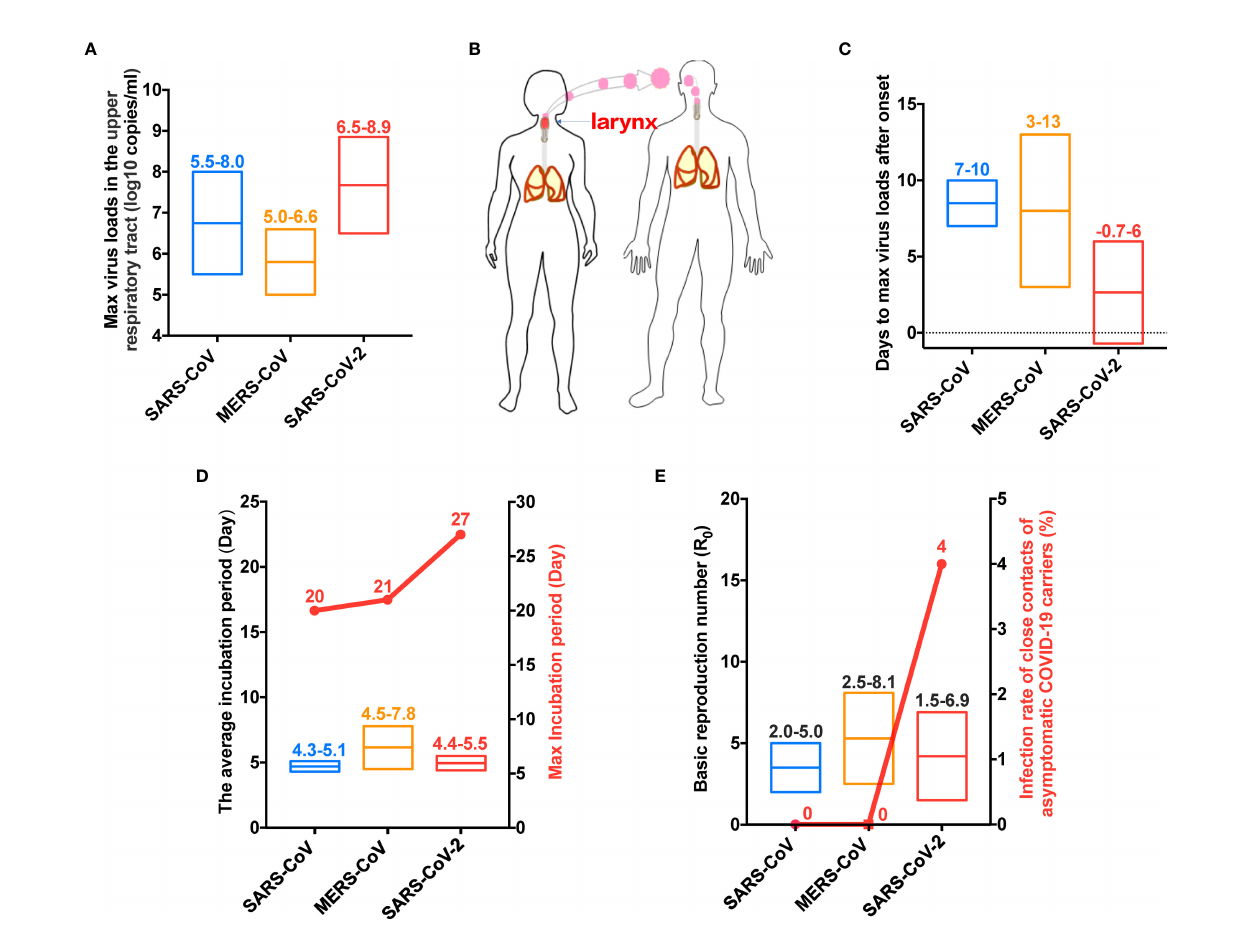
FIGURE 3 | COVID-19 has speci fi c virologiccharacteristics. (A) SARS-CoV-2 was associated with the highestviral load inthe upper respiratory tract. (B) SARS-CoV-2 primarily replicated inthe larynxin the early stage. (C) SARS-CoV-2 hadthe shortesttime to peak viral load in the upper respiratory tract. (D) SARS-CoV-2 had the longest maximal incubation period. (E) SARS-CoV-2 had a highbasic reproduction number (R0),but the key was the hidden transmission ability.SARS-CoV, Severe acute respiratory syndrome coronavirus; MERS-CoV, MiddleEast respiratorysyndrome coronavirus. SARS-CoV-2, Severe acute respiratory syndrome coronavirus